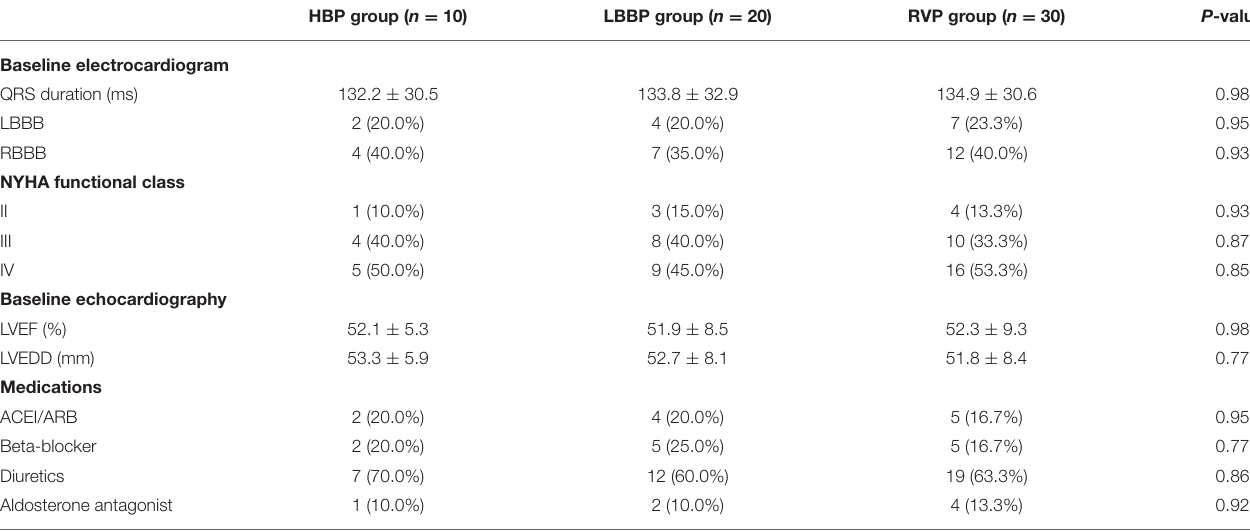
TABLE 2 | Baseline characteristics among groups.